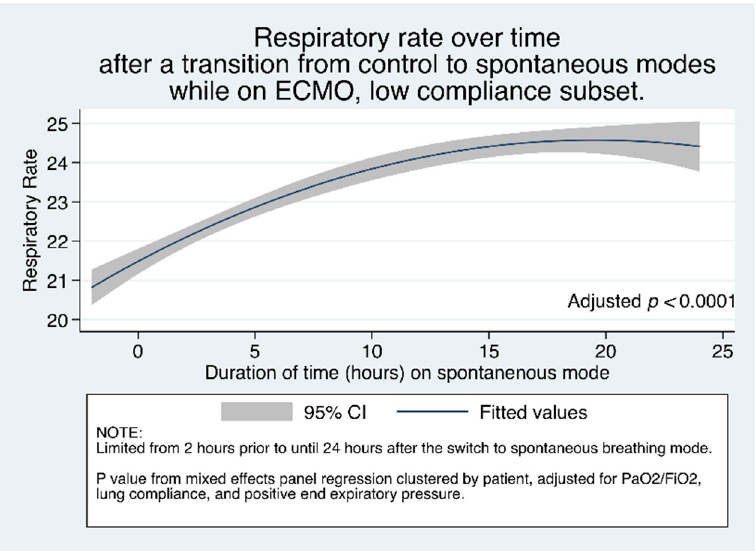
Figure 4. Respiratory rate over time after a transition from control to spontaneous modes while on ECMO, among patients with low compliance (<30 mL/cmH 2 O). p value reflects multivariate mixed effect regression, clustered by patient.